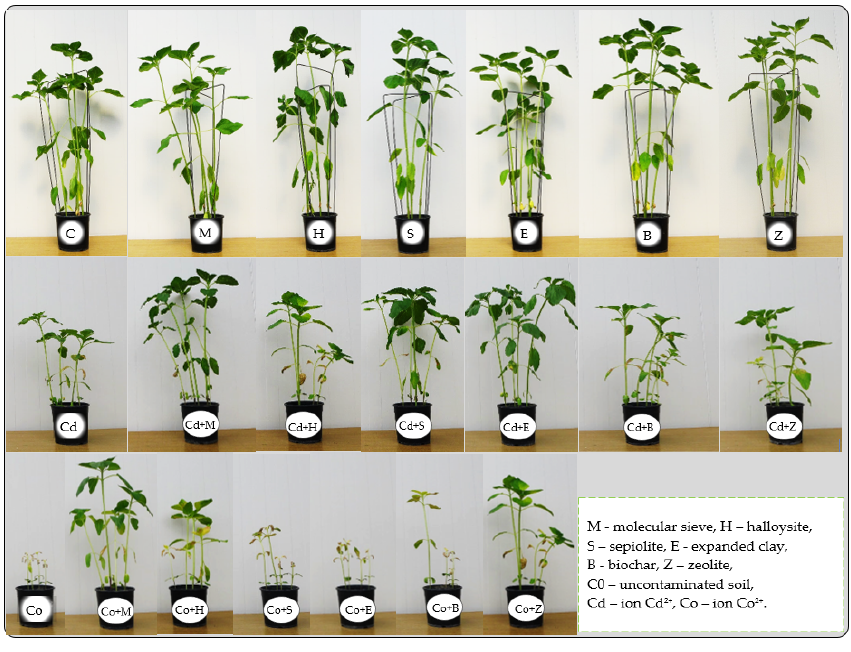
Figure 6. Helianthus annuus L. in the BBCH phase 34.